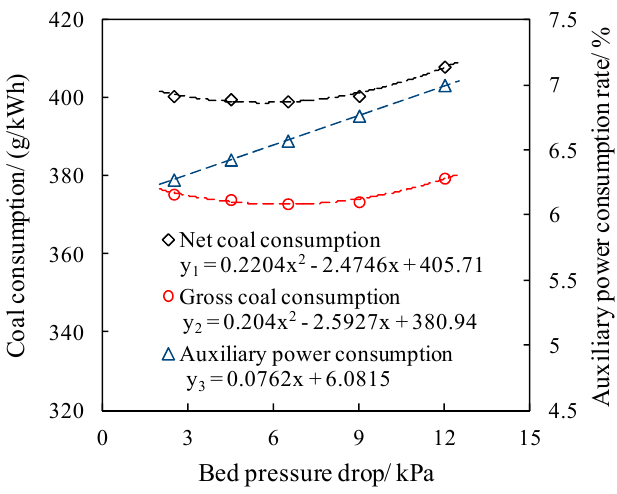
Figure 13. E ff ect of bed pressure drop on coal Figure 13. Effect of bed pressure drop on coal consumption.